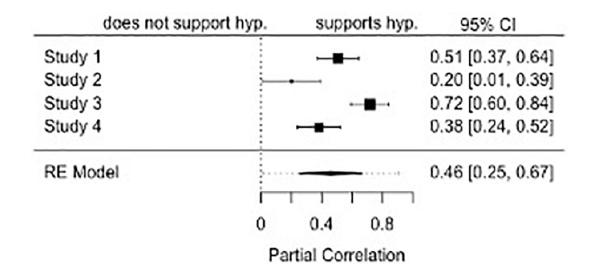
FIGURE 1 | A forest plot of the meta-analyzed effect of attitude similarity on affective attraction.